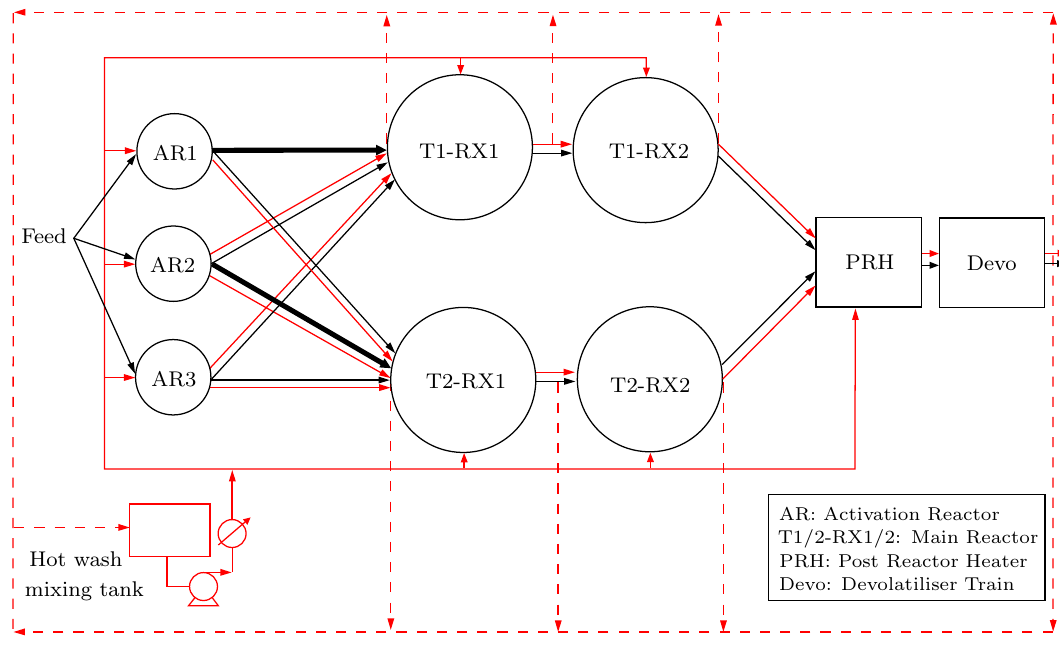
Figure 1: Reactor flow sheet for an ethylene tetramerisation